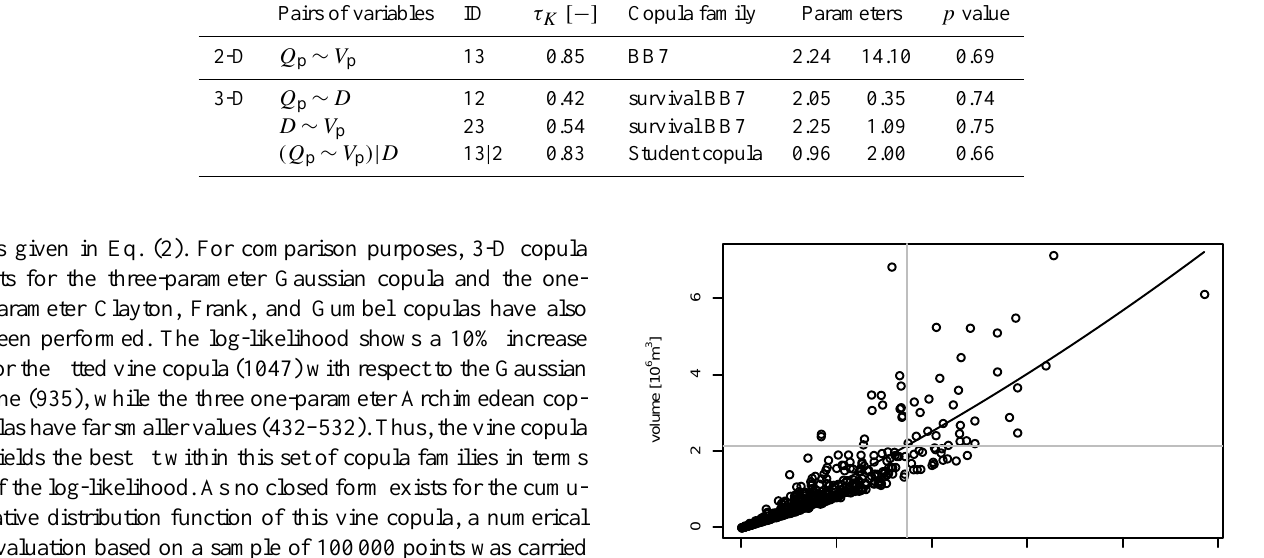
Table 2. An overview of the fitted bivariate copulas in the 2-D copula-based and 3-D vine copula-based approach. Pairs of variables ID τ K [−]